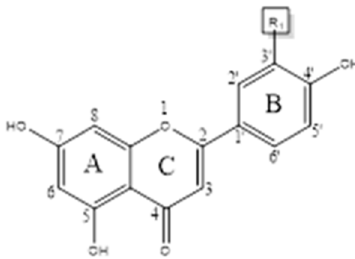
Figure 1. General structure of quercetin and kaempferol. Two phenyl rings (A and C) and a heterocyclic ring B. If R 1 = OH, Quercetin; if R 1 = H, Kaempferol.